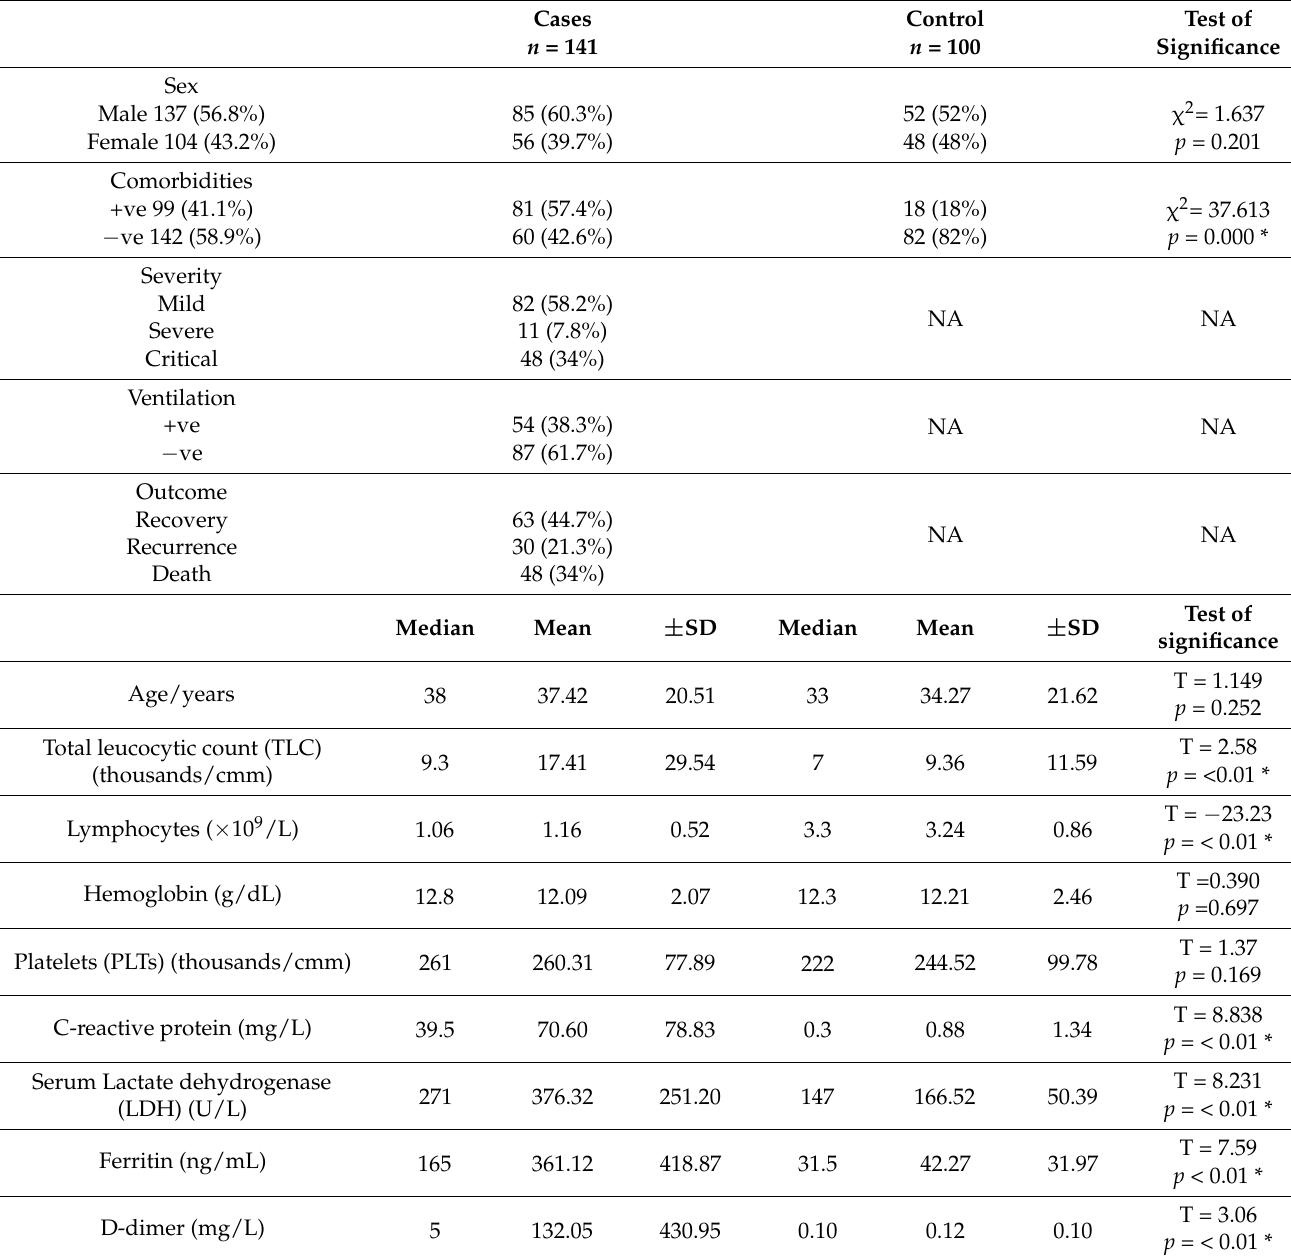
Table 1. Clinicopathological and laboratory data between the investigated